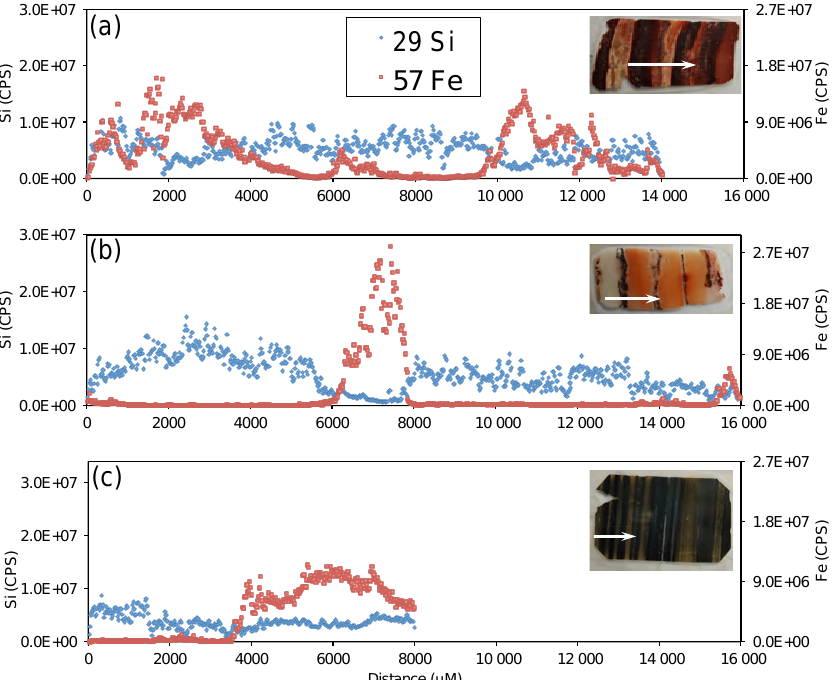
Figure 11. Fluctuation in Si and Fe content measured by in situ laser ablation ICP-MS analysis. (a) Milos BIF-type rock with evenly distributed Si- and Fe-rich bands. (b) Milos BIF-type rock with wide Si-rich (whitish–brownish strips) and narrow Fe-rich bands (dark strips). (c) An example of the 2.5Ga Kuruman BIF. Insets are analyzed thin sections. For scale, each thin section is ≈ 3.3cm long, in the direction of the arrows indicating the area